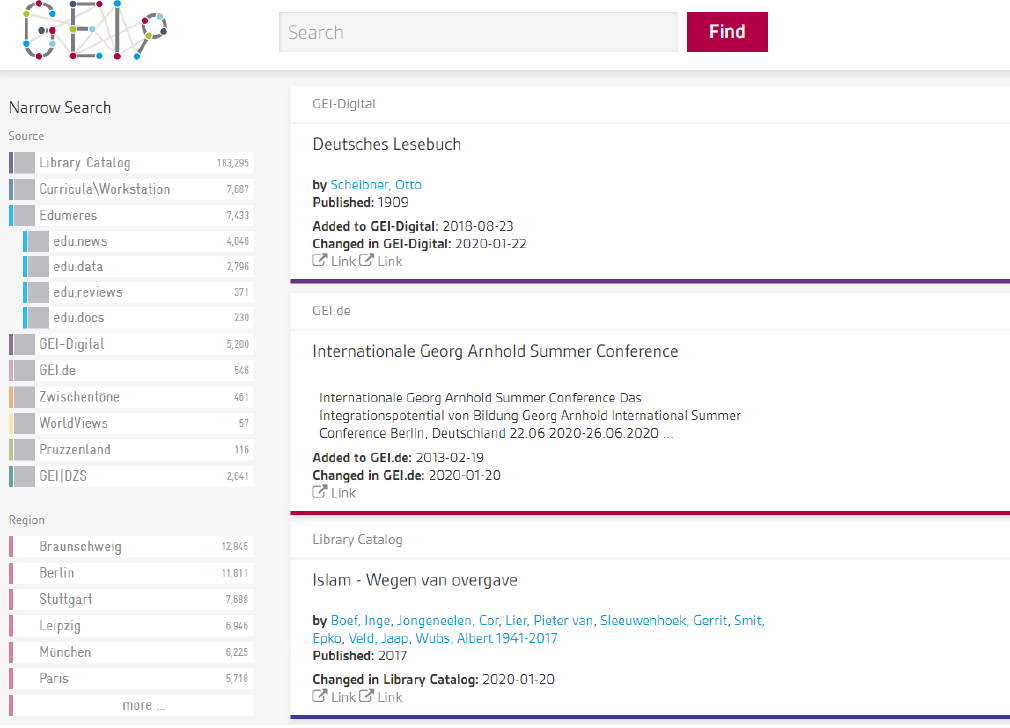
Figure 6. Meta search of data